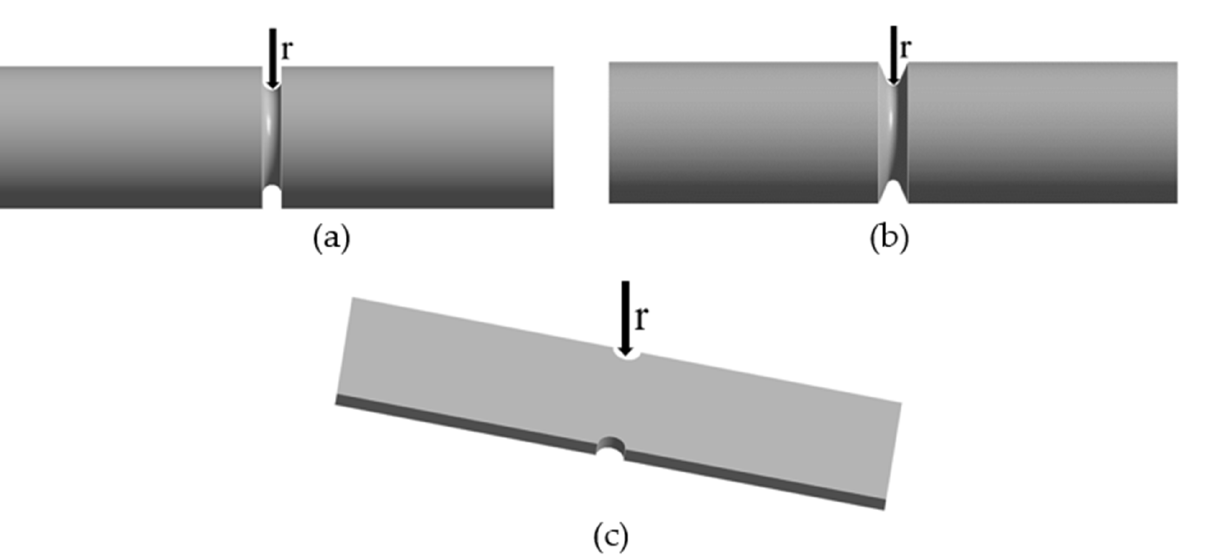
(c) Figure 5. Notched specimen relative stress gradient ( a ) r = 0.2 mm; ( b ) r = 0.6 mm; ( c ) r = 1 mm (elastic–plastic conditions). The stress gradient effect arises because of the support of the low ‐ stress region to the high ‐ stress region. For a smooth specimen with stress distribution σ ( x ) ≡ σ ns and relative stress gradient distribution χ ( x ) ≡ 0, there is no gradient e ff ect. Ideally, we can define the region Ω containing all relative stress gradients near the notch that are nonzero as the stress gradient influence range. However, even for the ideal semi ‐ infinite plane, the range defined by a relative stress gradient equal to 0 is not achievable because the relative stress gradient cannot be taken to be 0 at any point. Moreover, if a critical relative stress gradient value is included to define the region, the model cannot be applied to smooth specimens or specimens with low maximum relative stress gradients (since their internal stress gra ‐ dients tend to be 0). To solve this problem, this paper targets the point where the stress is equal to the nominal stress; to define the influence range, the region above the nominal stress is the influence range of the stress gradient L χ , The schematic diagram is shown in Figure 6. For smooth specimens, the range is 0 because the stress in the cross ‐ section is equal to the nominal stress everywhere, while for non ‐ smooth specimens, the maximum stress is inevitably higher than the nominal stress, so there must be a stress point on its stress curve, as the nominal stress point is shown in the diagram. By this definition, the stress gradient correction model of any notched specimen can be represented by a model.